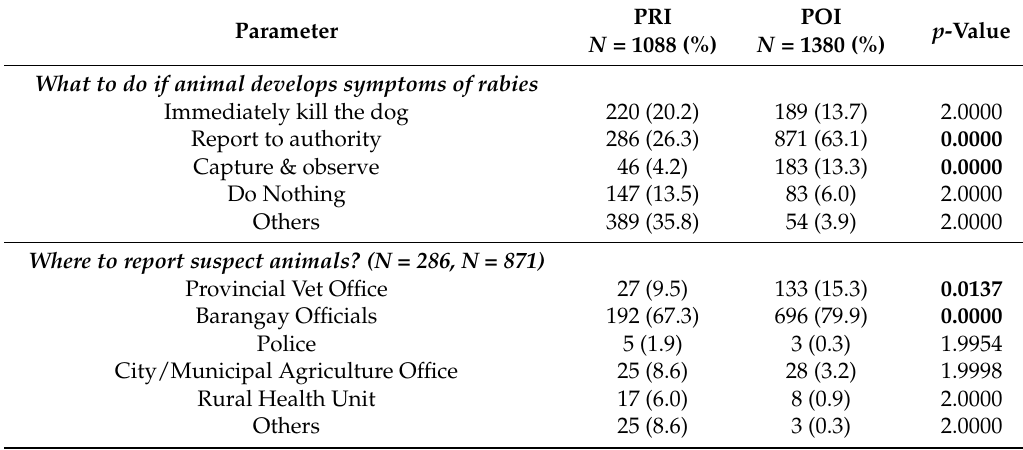
Table 5. Attitude towards suspect rabid animal sightings.